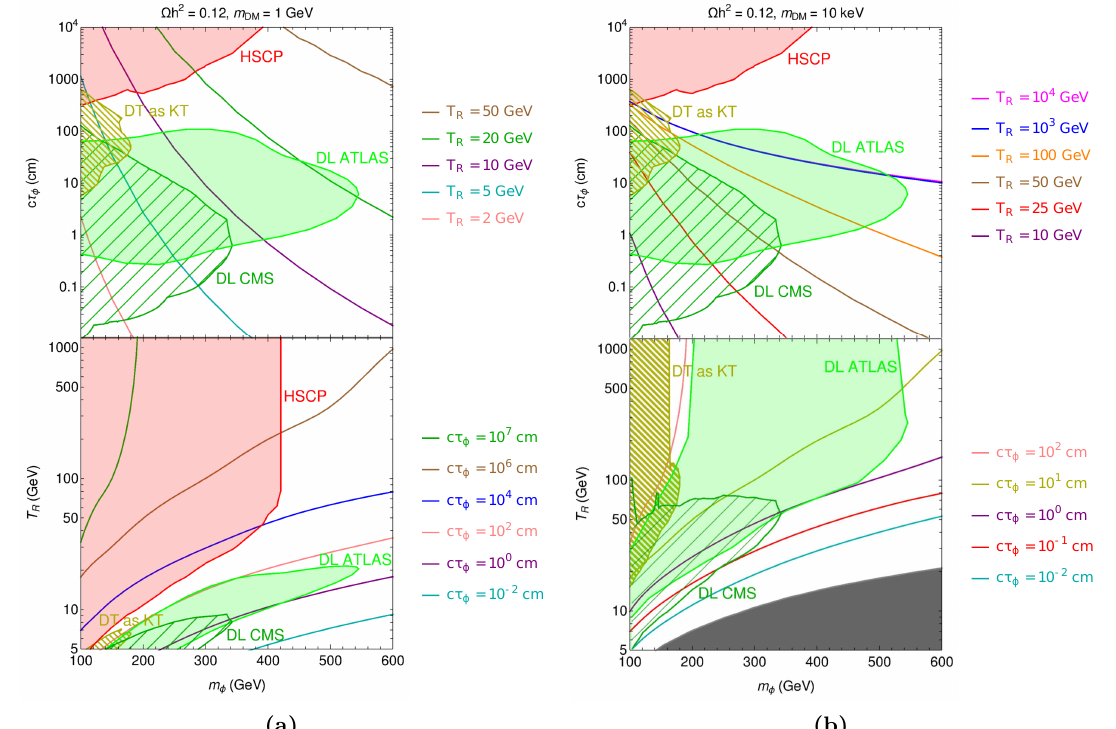
Figure 9. Leptophilic DM with m χ = 1 GeV (left) and m χ = 10 keV (right). The upper panel shows constraints in the ( m ) plane while the lower panel identifies the viable parameter space φ , cτ φ in the ( m ) plane. Solid lines reproduce the observed relic density, and the color code is the φ , T R same as in figure 8. The value of T associated to a given ( m ) in the right panel essentially R φ , cτ φ provides an upper bound on T for any dark matter mass as m & 10 keV due to small scale R χ structures constraints, see the text for